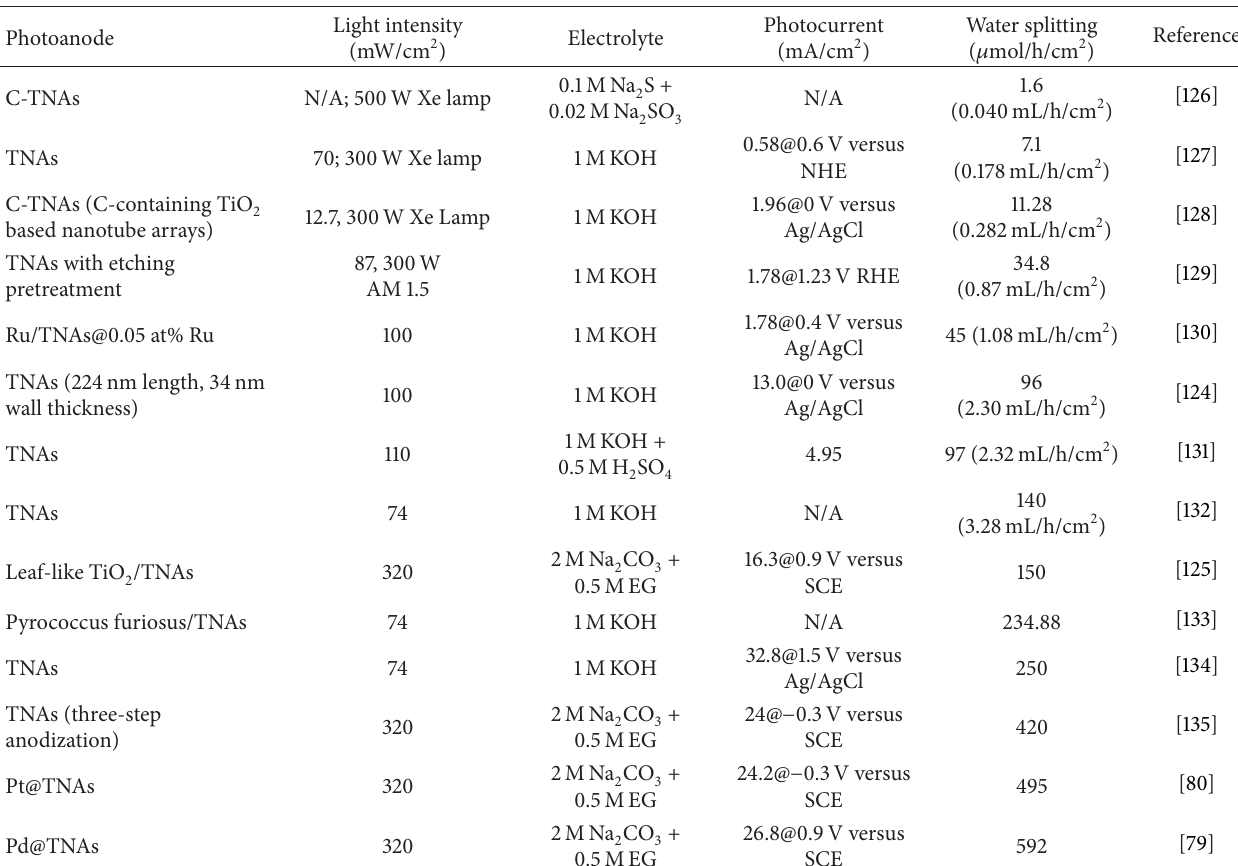
Table 2: Summary of TNAs based materials in water